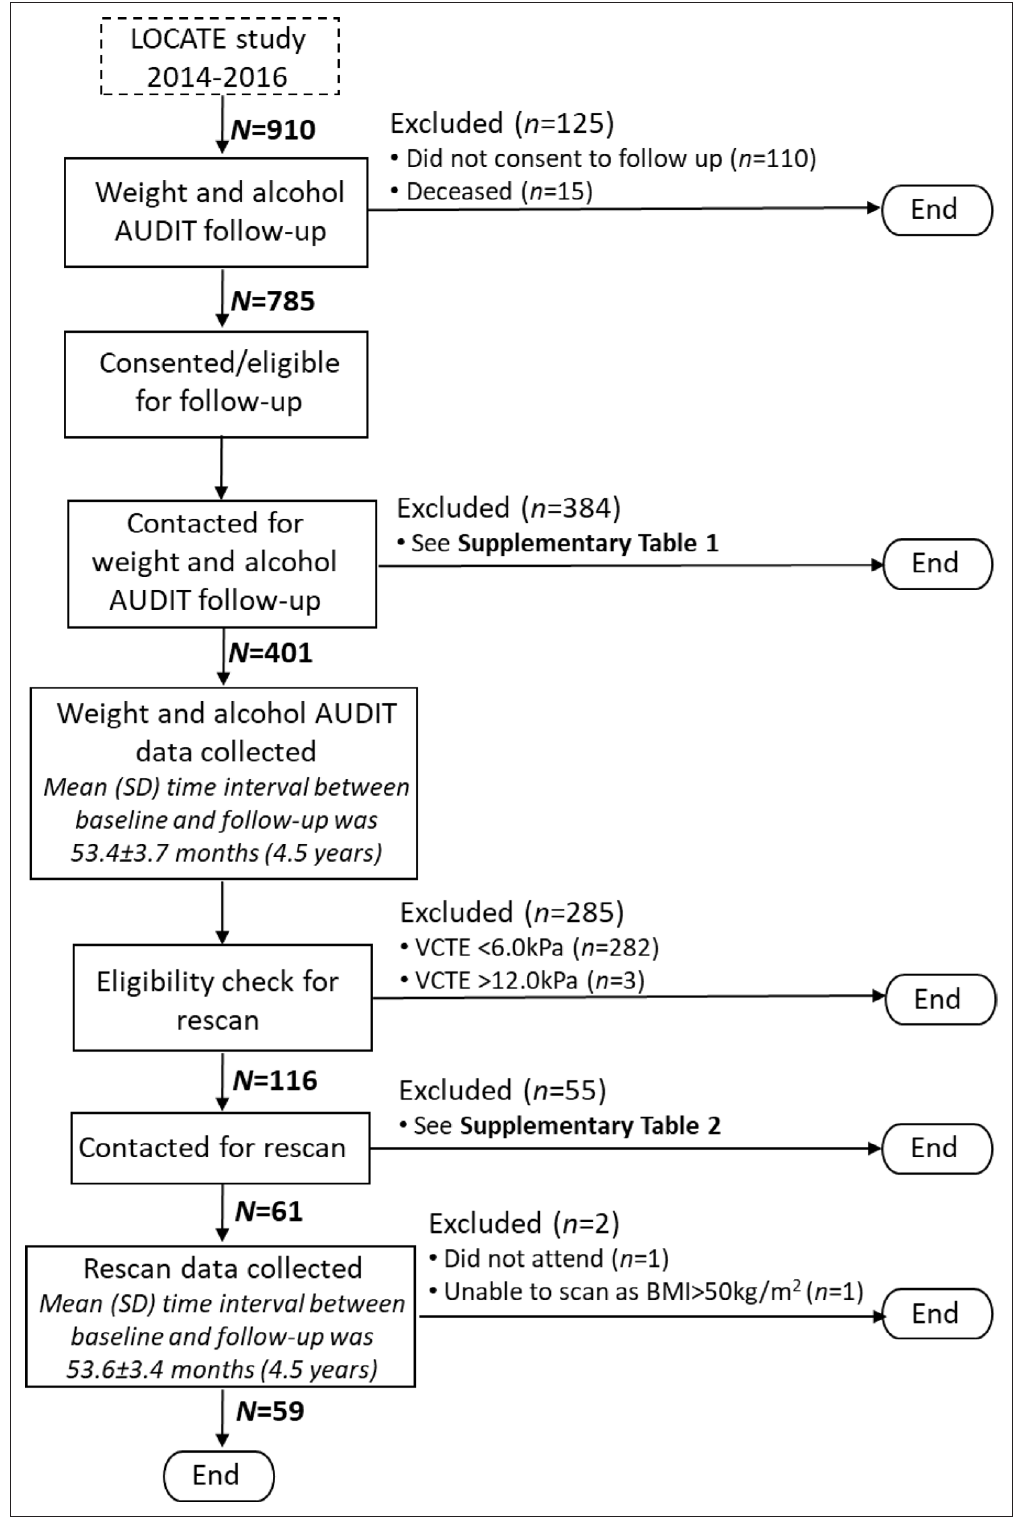
Figure 1 Flow of participants through the LOCATE follow- up study. AUDIT = Alcohol Use Disorders Identification Test. BMI = body mass index. VCTE = vibration- controlled transient